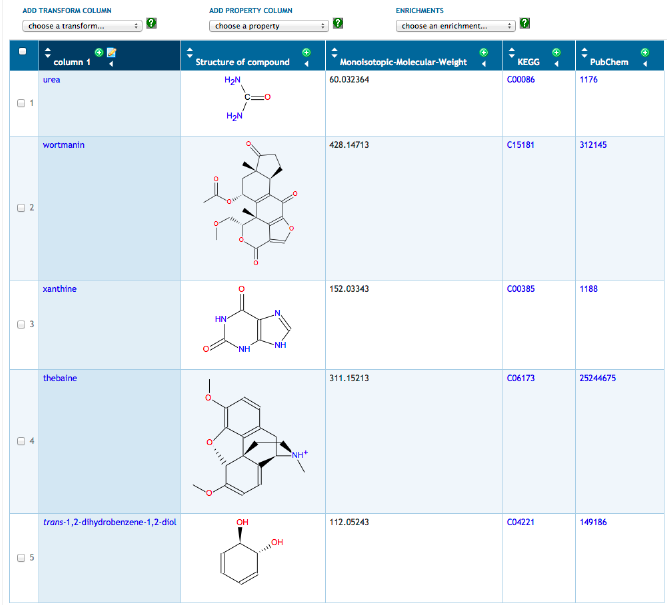
Figure 1. Metabolite SmartTable containing 125 metabolites from Chen, 2012; the first five metabolites are shown here because of space limitations.